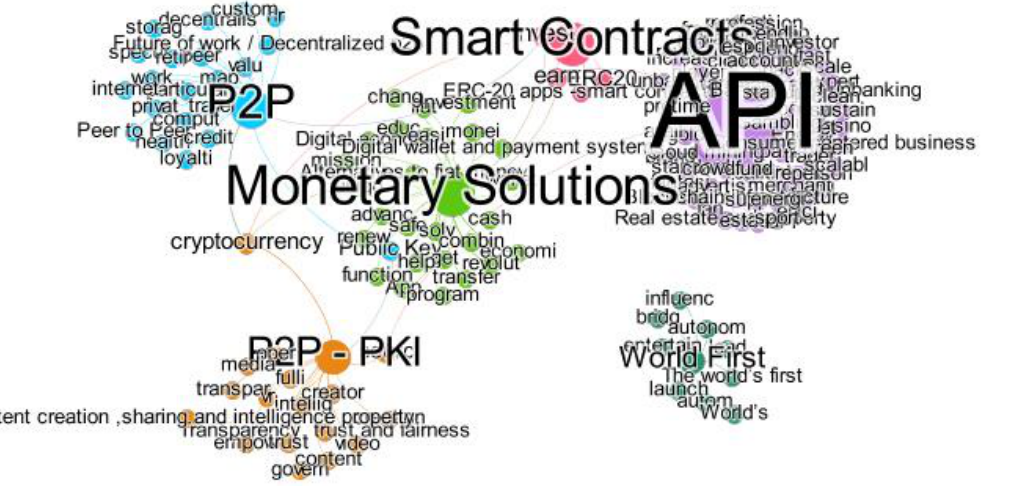
Figure 3. An overview of the LSA results.